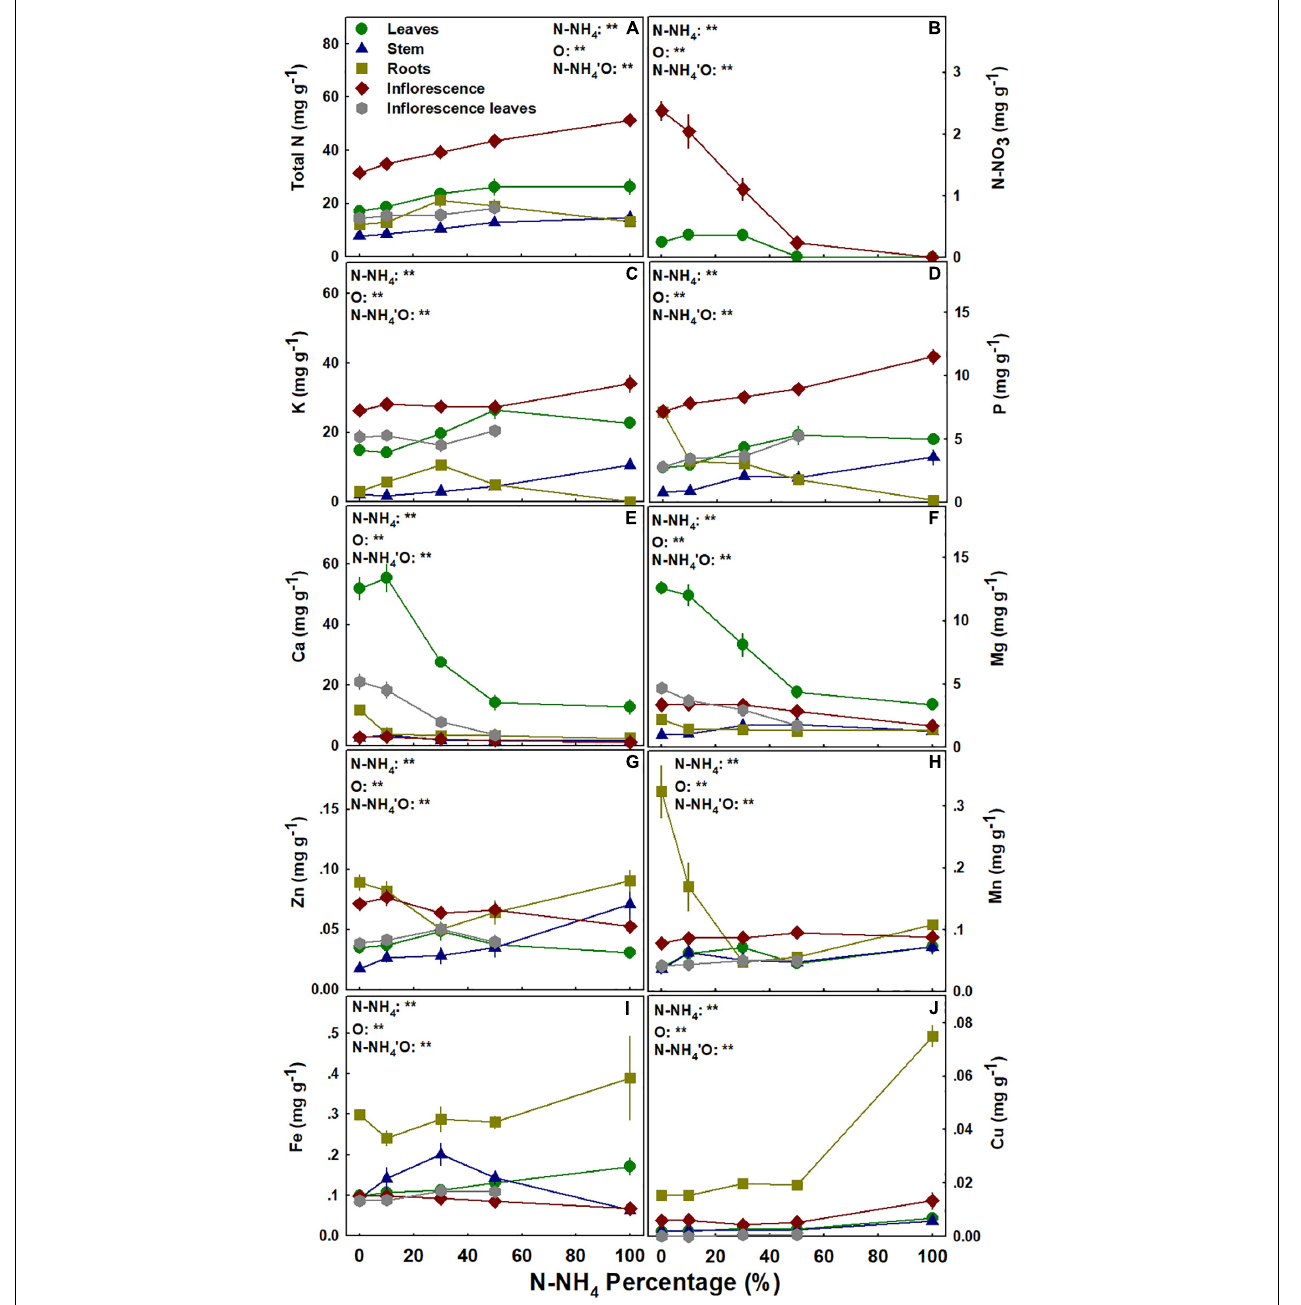
FIGURE 7 | Effect of NH 4 /NO 3 ratio on nutrient concentration in medical cannabis plants. Total N (A) , N-NO 3 (B) , K (C) , P (D) , Ca (E) , Mg (F) , Zn (G) , Mn (H) , Fe (I) , and Cu (J) . Presented data are averages ± SE ( n = 5). Results of two-way ANOVA indicated as ** P < 0.05, F -test; NS, not significant P > 0.05, F -test. In the ANOVA results N-NH 4 ’O represents the interaction between NH 4 /NO 3 ratio and plant